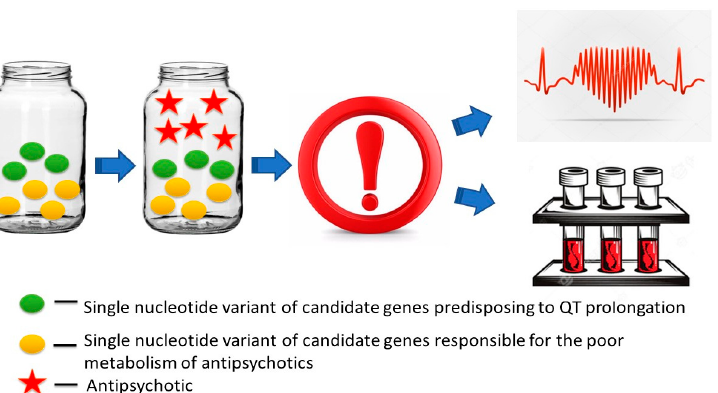
Figure 11. Genetic biomarkers of the risk of antipsychotic-induced long QT interval prolongation.